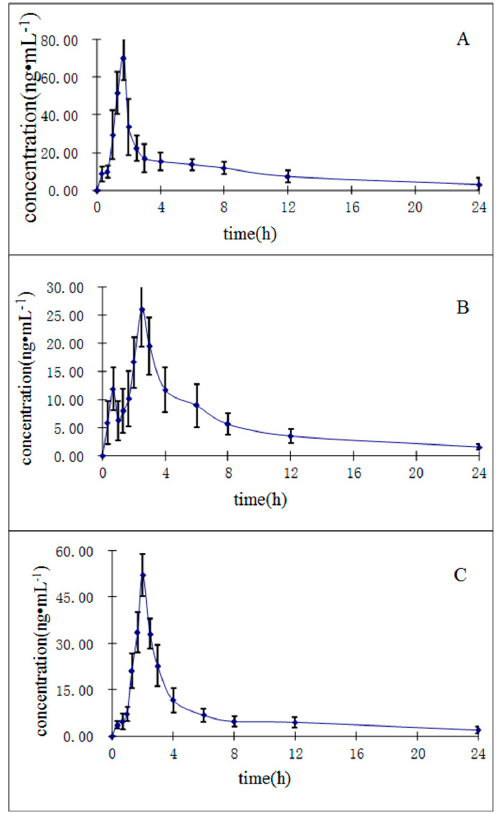
Figure 4. Mean ± SD ( n = 12) plasma concentration-time profiles of purpurin ( A ); munjistin ( B ); and mollugin ( C ) in rats after oral administration of R. cordifolia extract.